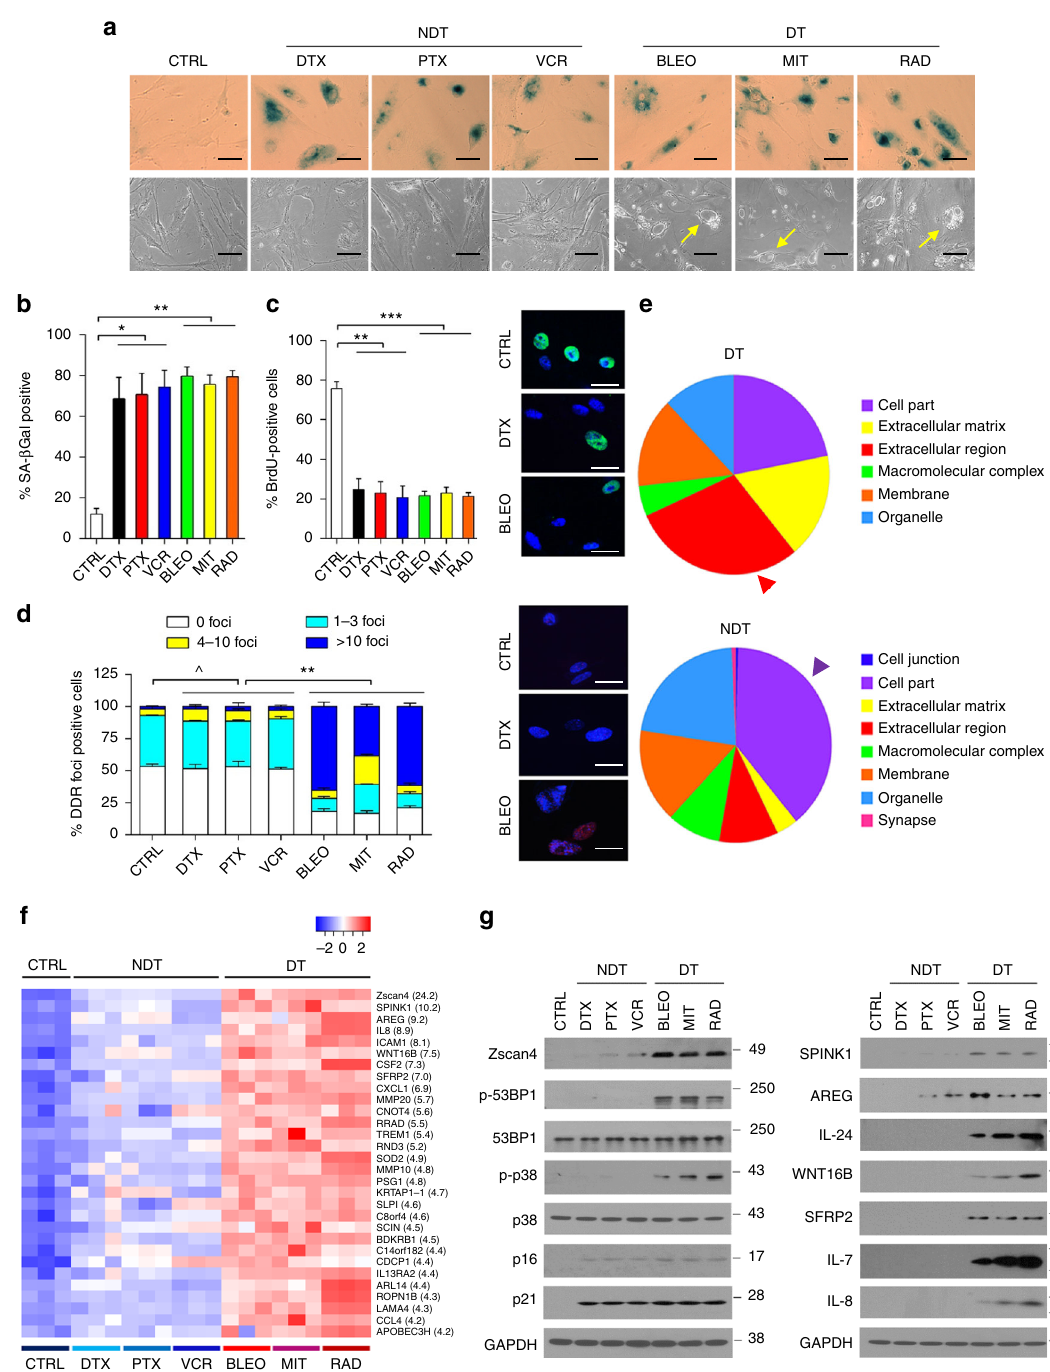
Fig. 1 Genotoxic treatments cause distinct gene expression in human stromal cells with remarkable Zscan4 upregulation. a Representative images of human stromal cell (PSC27) senescence, developed 7 – 10 d after treatment by two different classes of anticancer agents. CTRL control, NDT non DNA-damaging treatment, DTX docetaxel, PTX paclitaxel, VCR vincristine, DT DNA-damaging treatment, BLEO bleomycin, MIT mitoxantrone, and RAD radiation. Upper panel, SA- β -Gal staining; lower panel, phase contrast. Yellow arrows, cytoplasmic vacuoles. Scale bars, 15 μ m. b SA- β -Gal staining statistics of cells in the individual groups of ( a ). Data obtained from counting of at least 200 cells per independent experiment, and analyzed using Student ’ s t -test. c BrdU incorporation pro fi les of cells in the individual groups of ( a ), with representative images provided on the right (CTRL/DTX/BLEO shown for example; green, BrdU; blue, DAPI). At least 200 cells counted per independent assay. Scale bars, 15 µ m. Data analyzed using Student ’ s t -test. d Quanti fi cation of DNA damage foci (DDF). The number of DDF per cell falls into each of the 0, 1 – 3, 4 – 10, and >10 counting categories. Right, representative images (CTRL/DTX/BLEO displayed for example; red, γ H2AX; blue, DAPI). At least 200 cells counted per sample. Scale bars, 15 µ m. Data analyzed using two-way ANOVA. e GO analysis (cellular component, top 100 genes) of cells treated by DT and NDT agents, respectively. Color annotations shown on the right of Panther pie charts. f Heatmap depiction of top 30 human genes signi fi cantly upregulated in stromal cells after treatment by DT agents, with expression pro fi les generated by NDT agents shown side-by-side for parallel comparison. Numeric values in the bracket per gene refer to the expression fold change of the DT groups against the control. g Immunoblot analysis of the expression or activation of proteins including Zscan4, 53BP1, p38, p16, p21, and a subset of canonical SASP factors. Unless noted, data in all bar plots are shown as mean±SD and representative of 3 biological replicates. * P <0.05, ** P < 0.01, *** P <0.001, ^ P